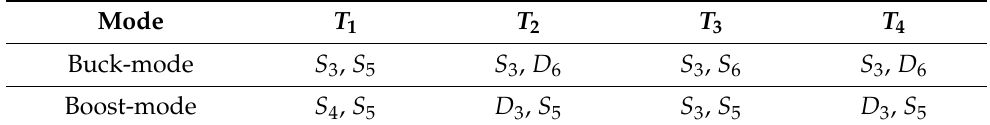
Table 7. Conduction of switches in different time intervals in Fuel cell to battery